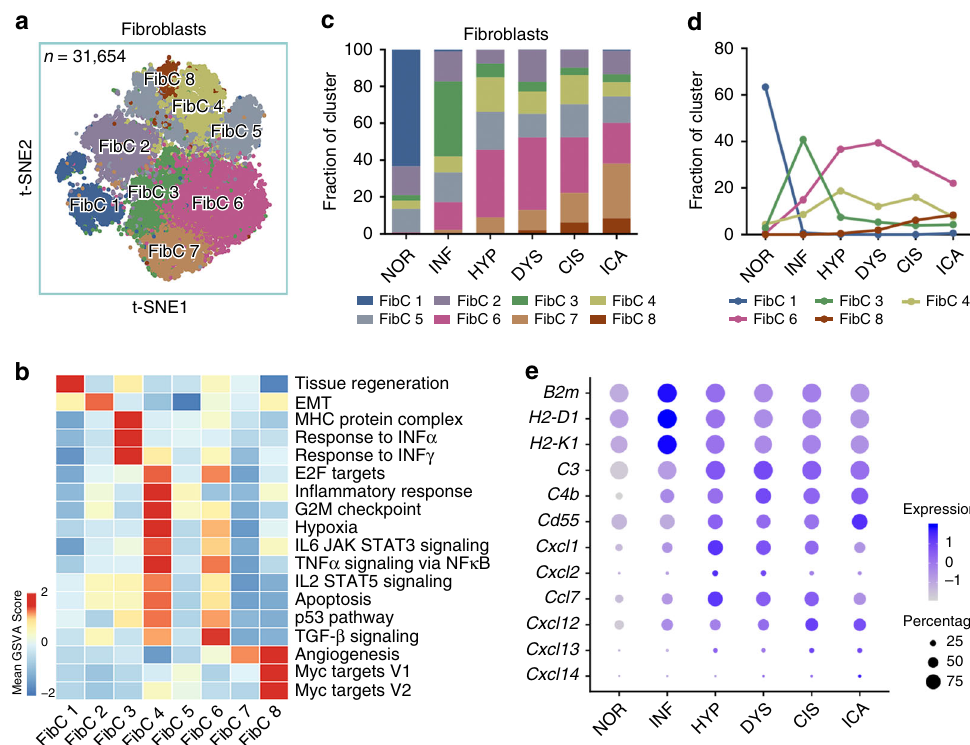
Fig. 4 Identi fi cation of fi broblast clusters and their expression features. a tSNE plot of 31,654 fi broblasts, colored by cluster. b Expression-based pathway activities scored by GSVA per fi broblast cluster. c Stacked histogram showing fi broblasts composition across the 6 pathological stages. d Line chart displaying changing trend of proportion of the four selected clusters across the six pathological stages. e Bubble plot showing scale normalized expression of representative genes involved in cytokine secretion, complement activity, and antigen presentation. Size of dots represents percentage of cells expressing corresponding genes in the